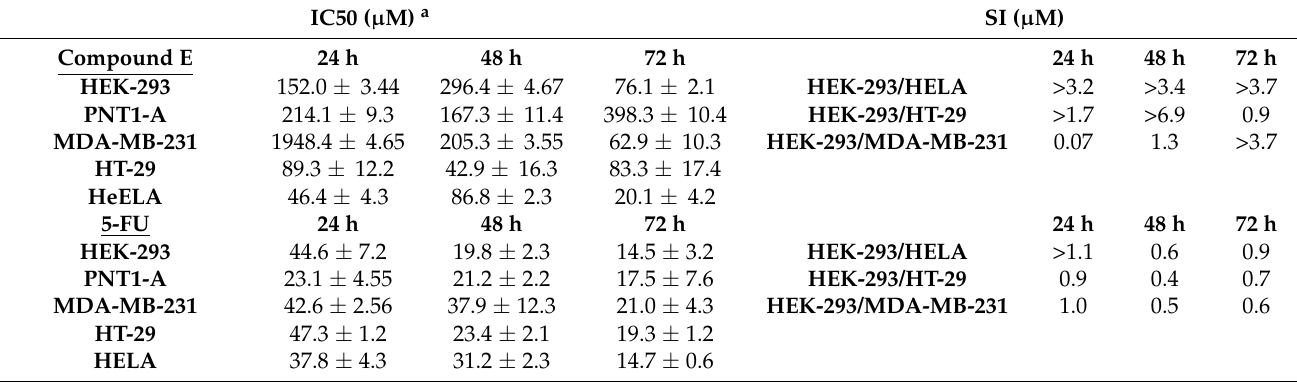
Figure 1. Antiproliferative effect of compound E in HeLa cells. Compound E decreased proliferation of HeLa cells in a dose-dependent manner. All data are expressed as mean ± SD values from three independent experiments. Table 1. Cytotoxicity of compound E and 5-Fluorouracil (5-FU) on cancer and normal cell lines (IC 50 and